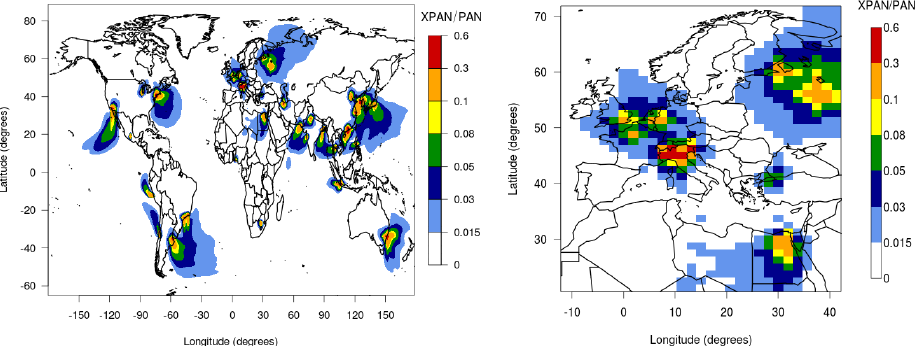
Fig. 6. Annual average ratio of tagged ozone from megacity emissions to total ozone. Surface ratio is shown both globally (left) and zoomed in over Europe (right).